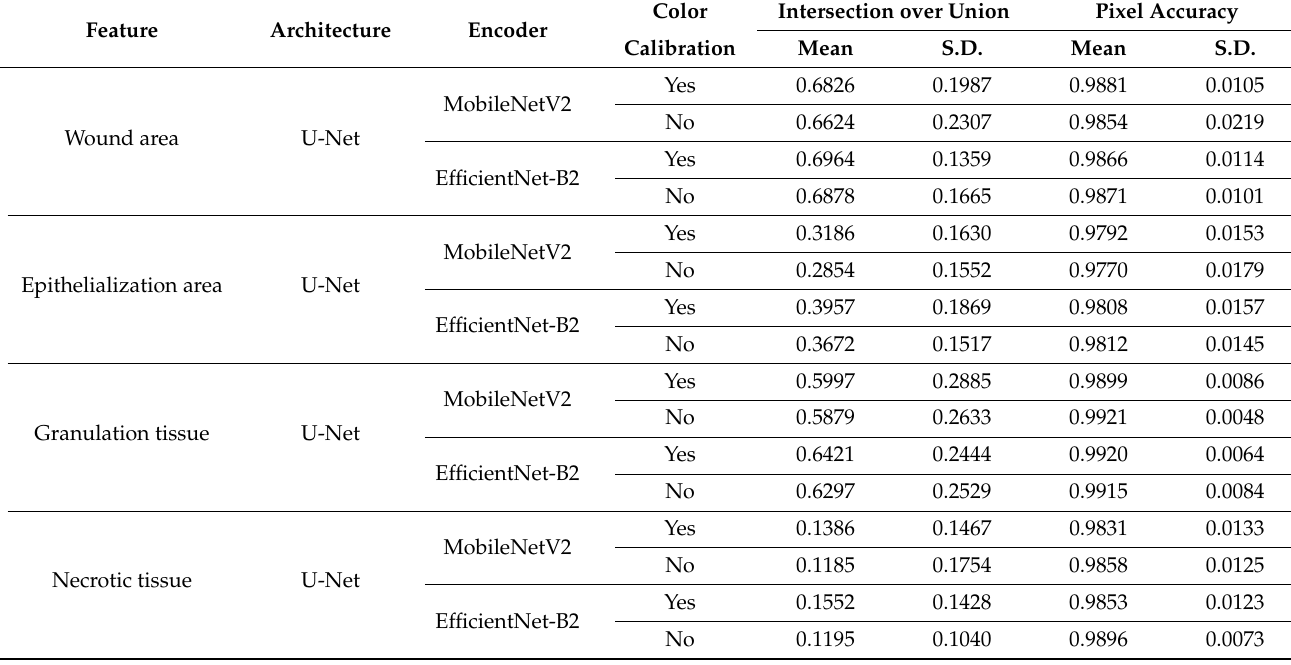
Table 5. Performance deep learning models for wound area and wound tissue